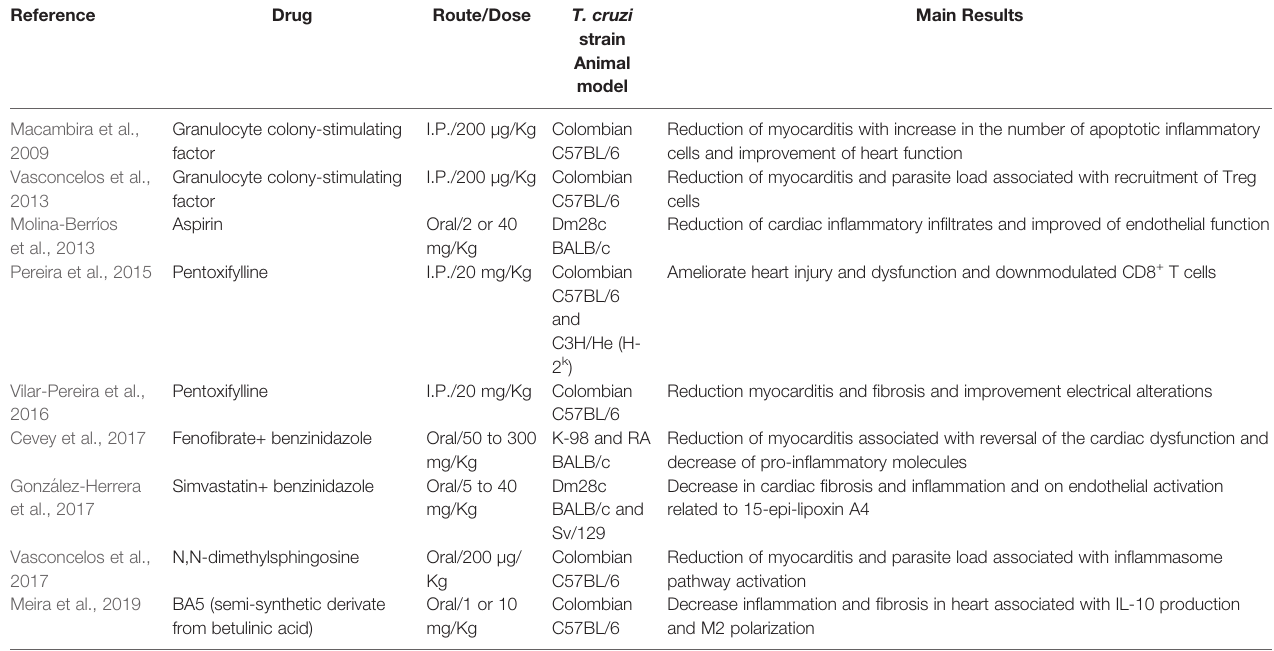
TABLE 1 | Immunomodulatory drugs used in CCC